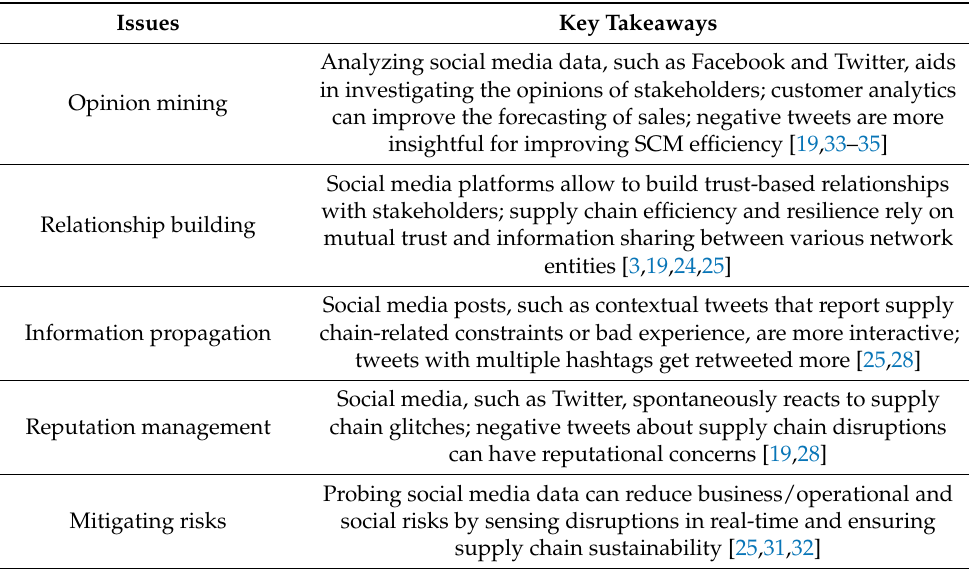
Table 1. AI-based approaches on social media data for